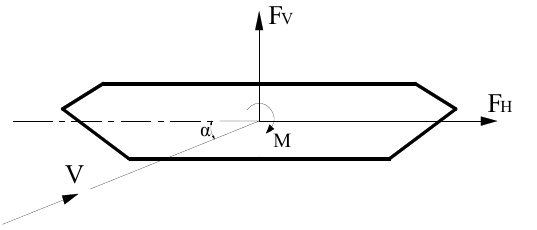
Figure 1. Three-component force on the girder section in the body axis coordinate system.